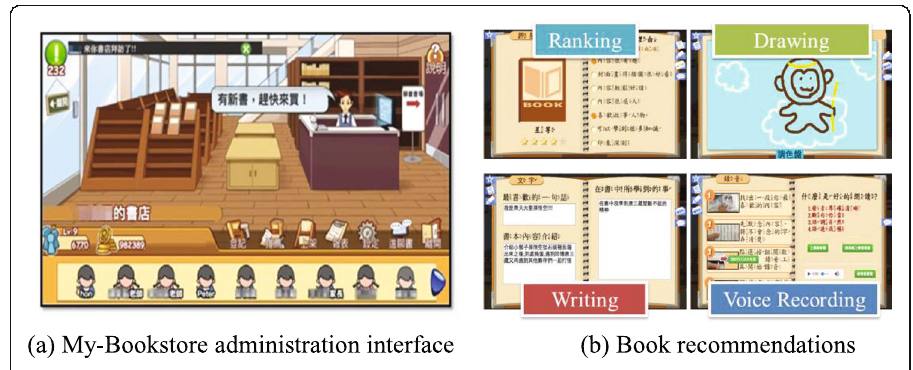
Fig. 3 My-bookstore system. a My-Bookstore administration interface. b Book